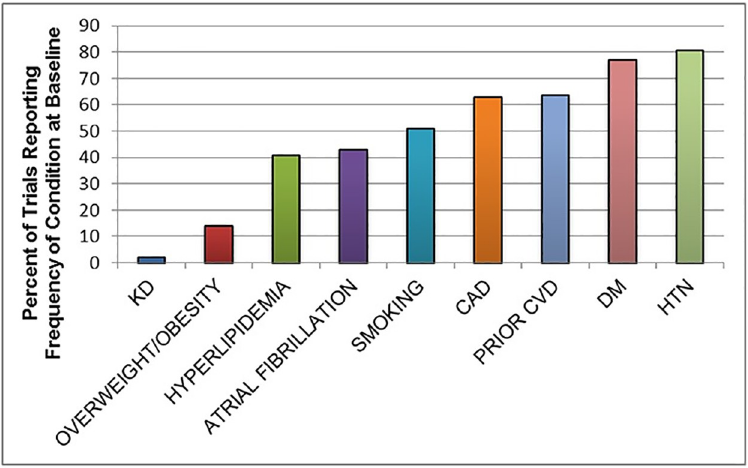
Fig 3. Bar chart of frequency of reporting of cerebrovascular disease risk factors in cerebrovascular trials. Abbreviations: KD (kidneydisease),CVD (cerebrovascular disease),CAD (coronary artery disease), DM (diabetesmellitus), HTN